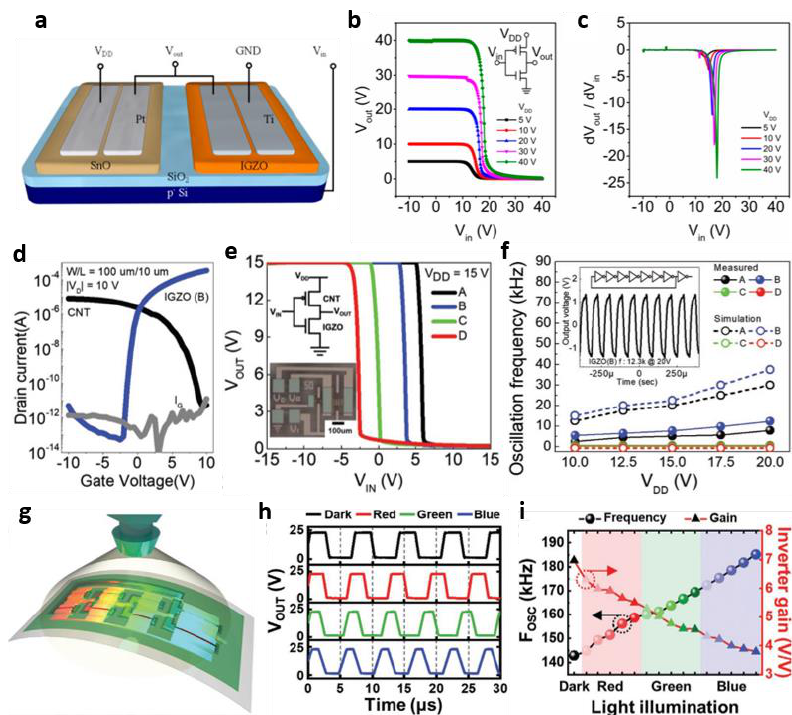
Figure 4. Metal-oxide-based digital thin-film circuits. ( a ) Structural illustration, ( b ) voltage transfer characteristics, and ( c ) gain of inverter composed of SnO and IGZO TFTs (adapted from [ 68 ] with permission from MDPI). ( d ) Transfer curves for optimal a-IGZO and SWCNT TFTs. € The voltage transfer characteristics of the CMOS inverter according to the deep ultraviolet irradiation time on IGZO TFT. ( f ) Simulated and measured oscillation frequencies as a function of V DD , and output characteristics of a CMOS seven-stage ring oscillator, when V DD = 20 V (adapted from [ 71 ] with permission from John Wiley and Sons). ( g ) Illustration in which light is irradiated to a three-stage ring oscillator based on a-IGZO and SWNT TFTs. ( h ) Output waveform, ( i ) oscillation frequency and gain of a three-stage ring oscillator according to the wavelength of light irradiated, such as red, green, and blue (adapted from [ 72 ] with permission from John Wiley and Sons).